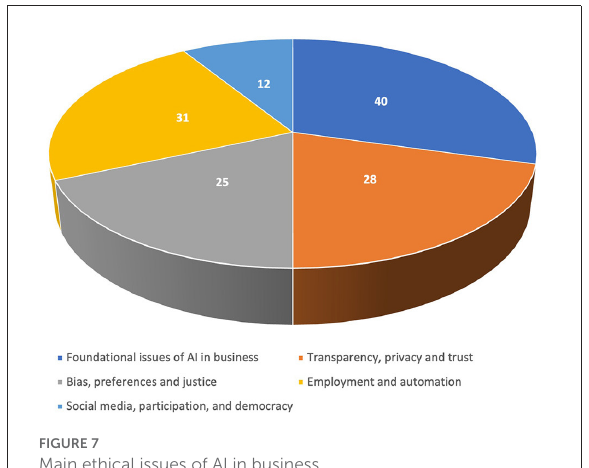
FIGURE7 Main ethical issues of AI in